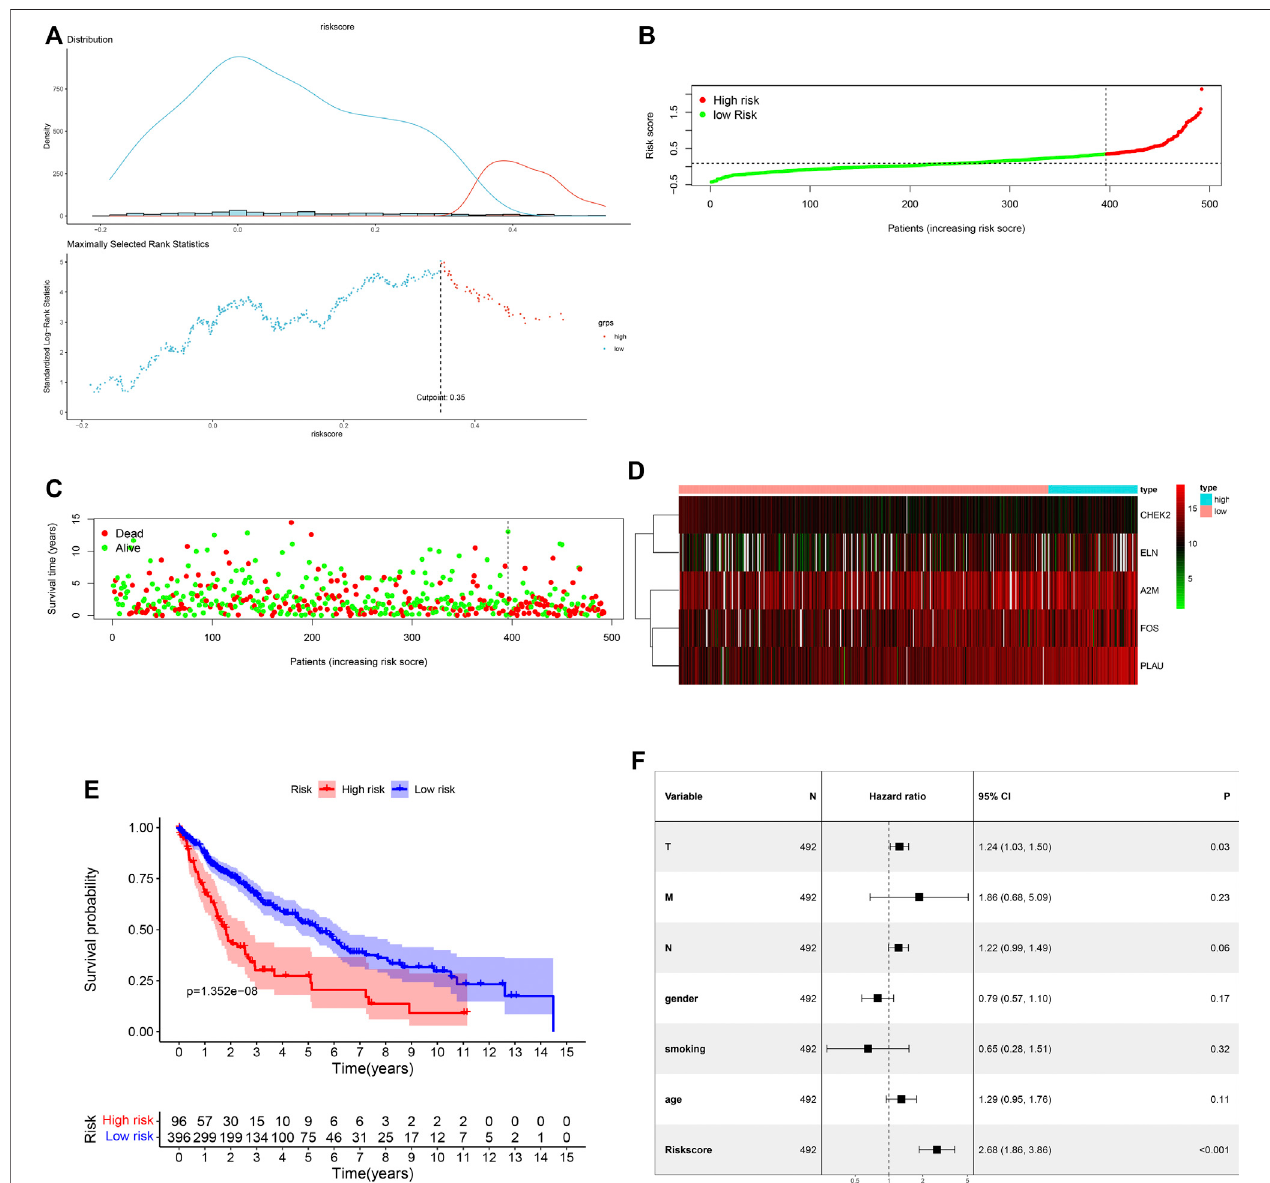
FIGURE 3 | Assessment of prognostic value of the ARG signature model in the TCGA training cohort. (A) Determination of cut-off value of ARG risk scores by the maximally selected log-rank statistics. (B) The distribution ofrisk scores inthe TCGA cohort. (C) Patient distribution inthe high- and low-risk groups according to overall survivalstatus. (D) Theheatmapshowingexpressionpro fi lesofthe fi veARGs. (E) Kaplan-Meiercurvesfortheoverallsurvivalofpatientsinthehigh-andlow-riskgroups. (F) Multivariate Cox regression analysis of the ARG signature and other clinicopathological factors.